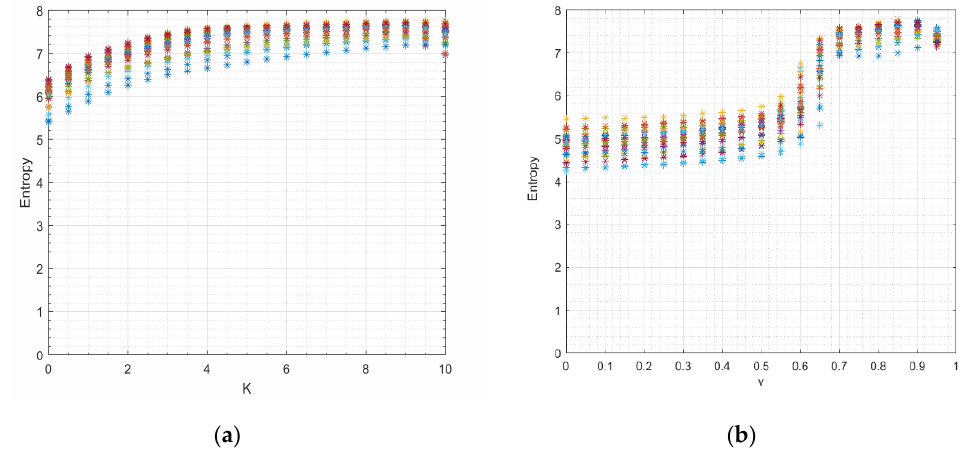
Figure 6. Information entropy with different parameters in the multispectral image dataset: ( a ) brightness adjustment parameter 𝐾 ; ( b ) fractional differential order 𝑣 .